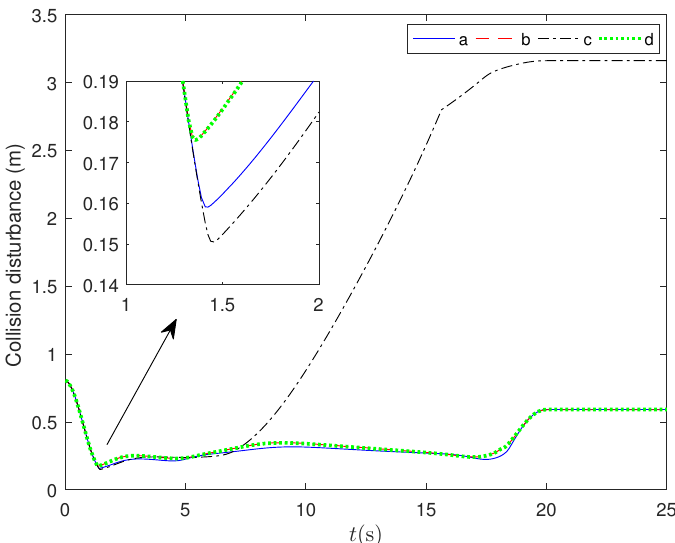
Figure 4. The fitness curve of dsRNA splicing evolutionary algorithm.